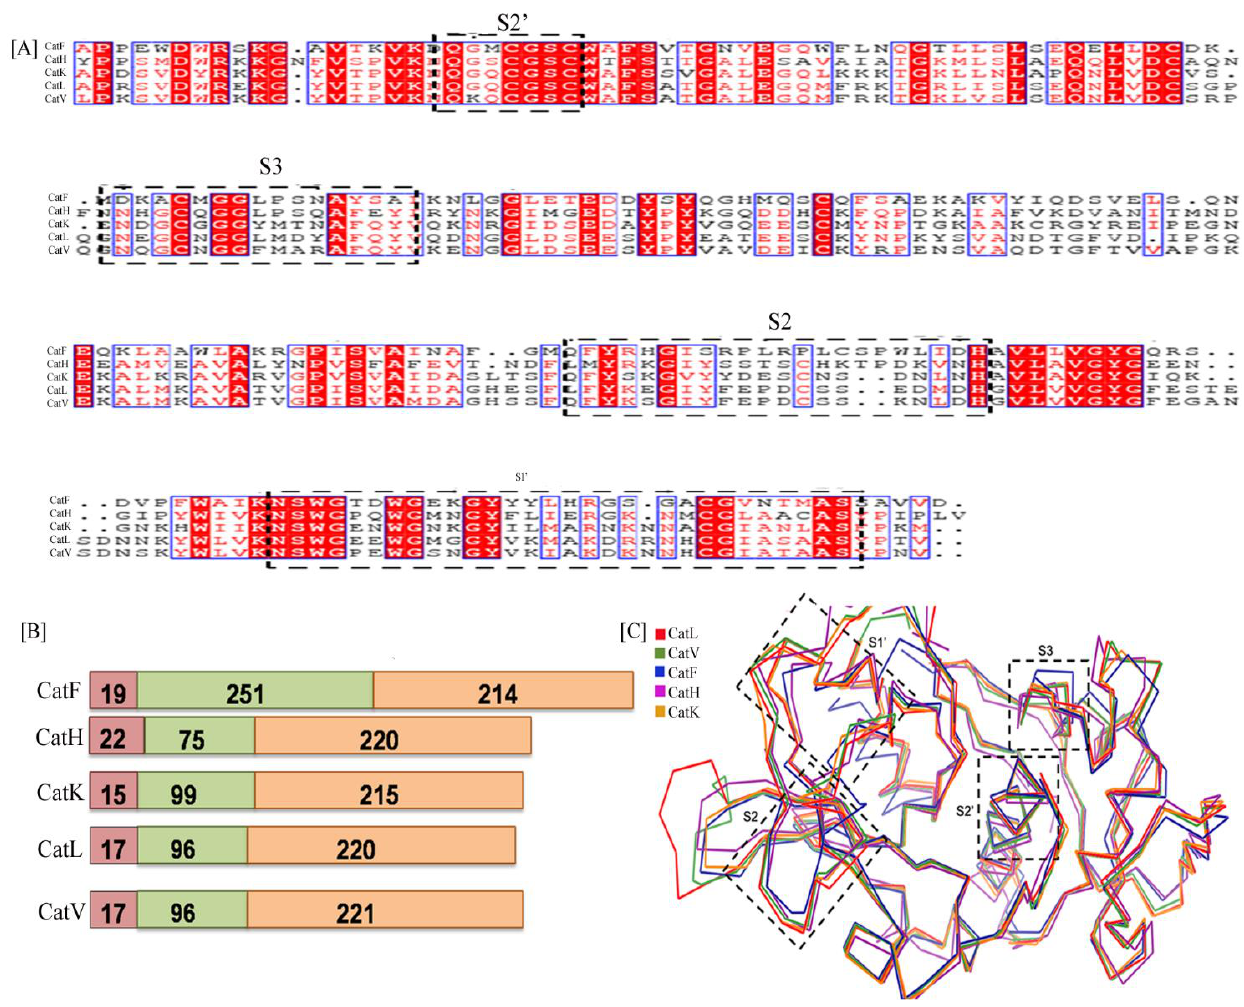
Figure 2. [A] . The multiple sequence alignment representation of different cathepsins namely CatL (PDB Id. 4AXL), CatK (PDB Id. 6ASH),CatV (PBD Id. 1FH0),CatH (PDB Id. 1NB3), CatF (PDB Id. 1M6D): figure generated by Clustal Omega and Espript3. The substrate binding subsites S 2′ , S3 of L-domain and S2, S 1′ of R-domain are highlighted with dotted box. The figure [highlighted in red] denotes sequence conservation of active site residues at their respective subsites. [B] . The do- main architecture of cathepsin indicates conservation in overall functional classification of domains SD represents the signal sequence domain, PD as prodomain, MD is the mature domain; Number of amino acid present in each domain is mentioned. [C] . Superposition of backbone traces of five cathepsins indicate sequence diversity in domains S1, S2, S3 and S 1′ has generated three dimensional perturbations.